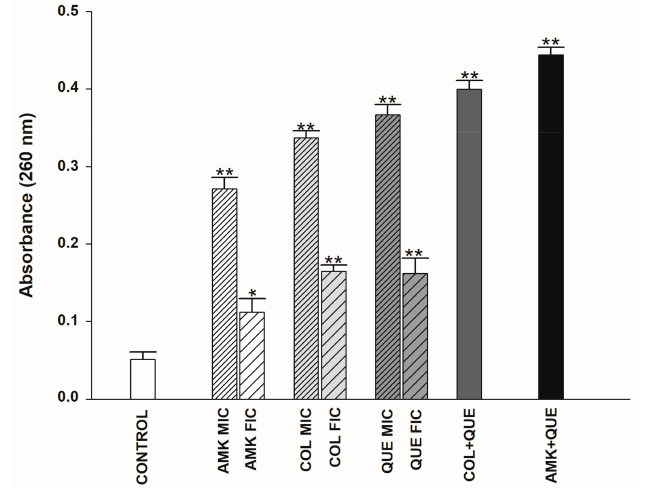
Figure 2. Presence of 260 nm absorbing materials in the supernatants of ColR-Ab4 strain treated with MIC and FIC values of QUE, COL, AMK, and synergistic concentrations of QUE + COL and QUE + AMK. The data are the average triplicates and * and ** significance at the levels of p < 0.05 and p < 0.01, respectively.